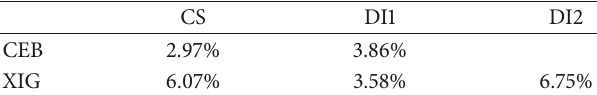
Table 4: The mean absolute deviation (MAD) of the theoretical prices of the CEB and XIG convertible bonds calculated by the CS method and the DI method with supposition that a default may occuronlyonthematuritydate(DI1),andpriortooronthematurity (DI2).